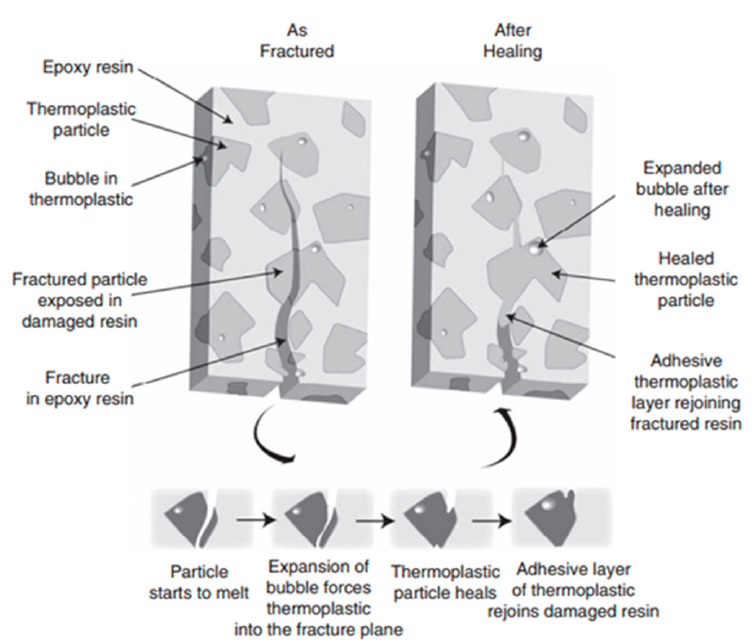
Figure 4. Healing agent delivery mechanism used by the mendable epoxy resins containing EMAA particles (reproduced from [57] with permission from Elsevier).